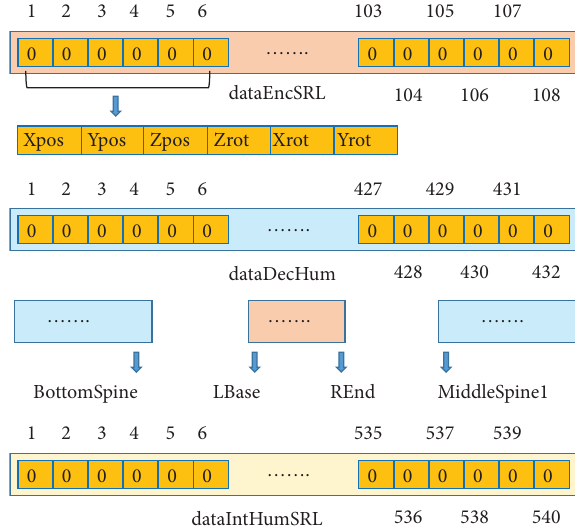
Figure 10: Schematic diagram of the integration of the two skeleton motion